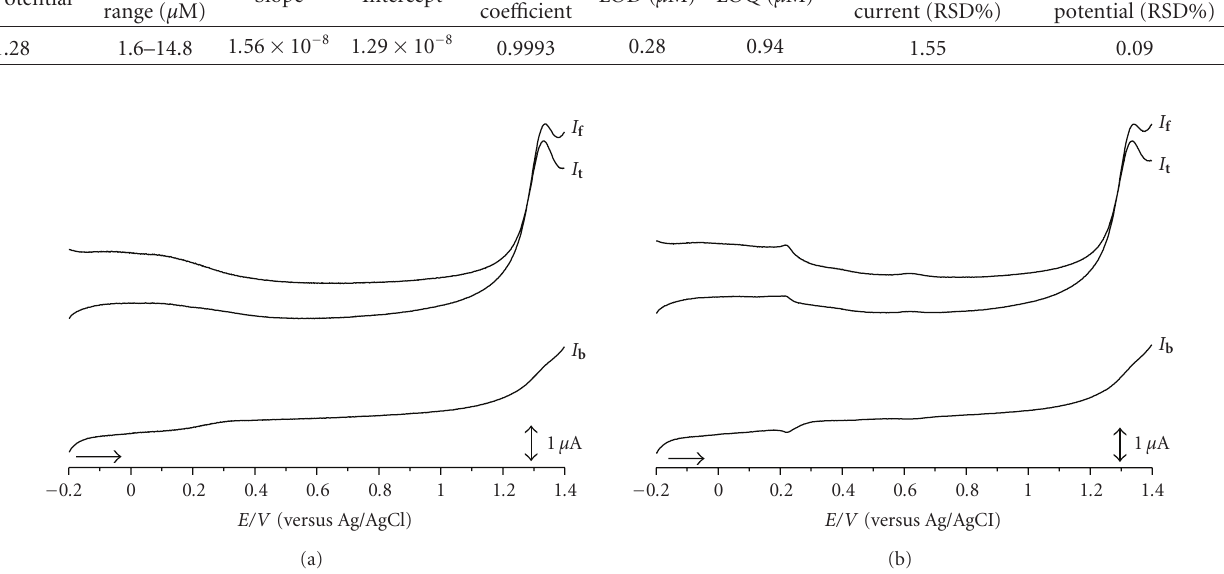
Figure 3: SW voltammograms of 100 μ M FLU in pH 6.1 0.1M phosphate bu ff er: (a) first scan, (b) second scan, f = 50 Hz, Δ E s = 2 mV, 1 pulse amplitude 100 mV, I t —total, I f —forward and I b —backward, and